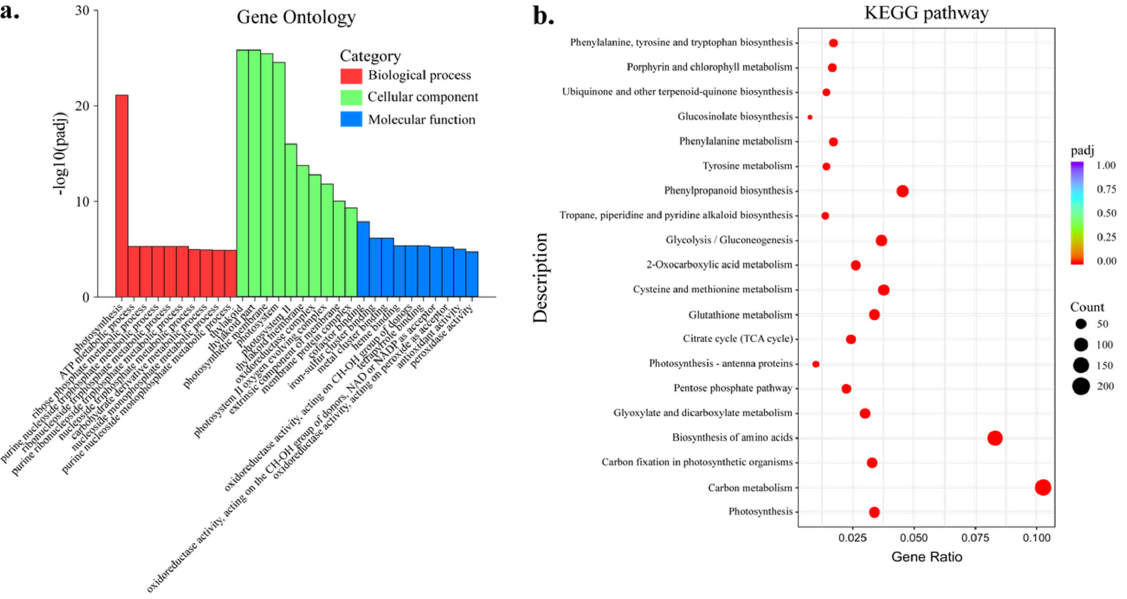
Figure 5. GO and KEGG analysis. ( a ) GO classification of the DEGs. ( b ) KEGG enrichment of the DEGs.